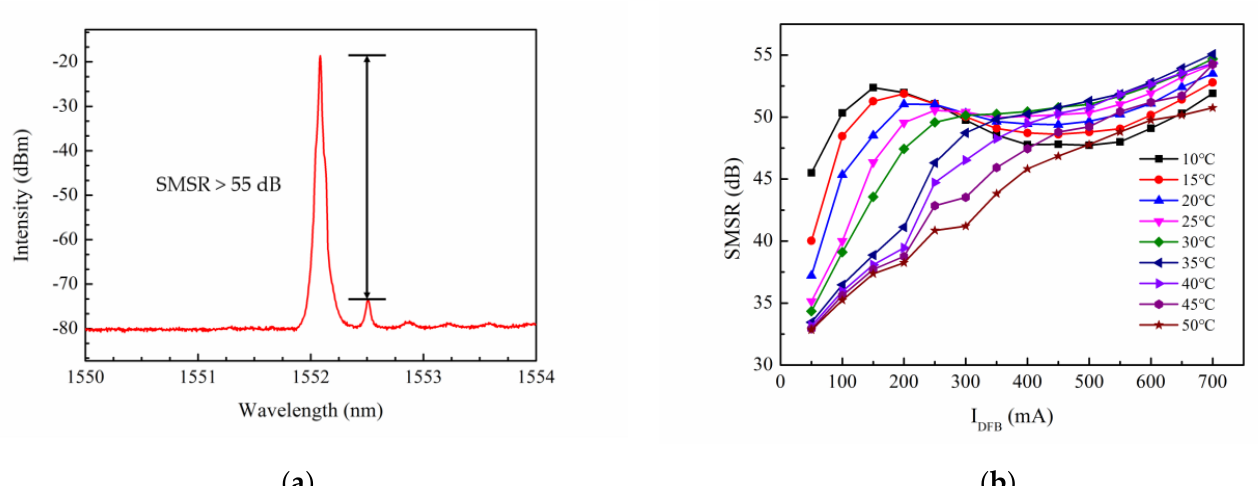
Figure 6. ( a ) SMSR of the device with I DFB = 700 mA at 20 °C; ( b ) SMSR at different temperatures and I DFB .